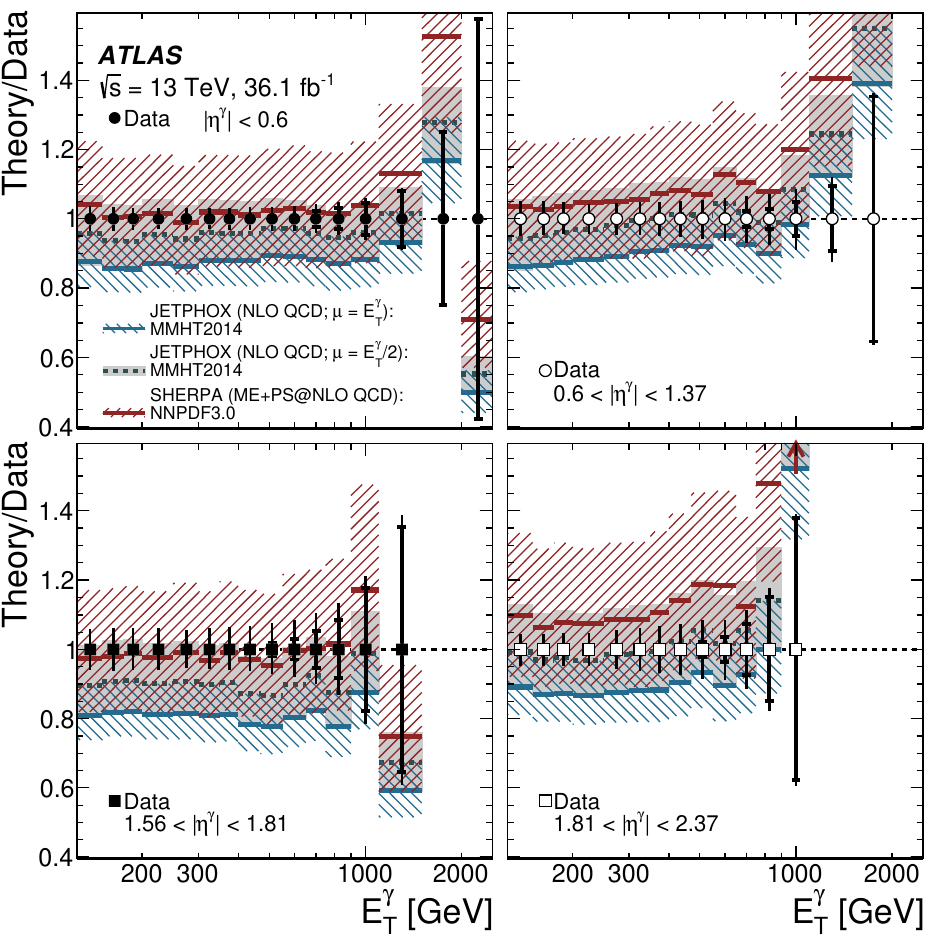
Figure 10 . The ratio of the NLO pQCD prediction of Jetphox with (cid:22) R = (cid:22) F = (cid:22) f = E (cid:13) , the T ratio of the NLO pQCD prediction of Jetphox with (cid:22) R = (cid:22) F = (cid:22) f = E (cid:13) = 2 and the ratio of T the ME+PS@NLO QCD prediction of Sherpa 2.2.2 to the measured di(cid:11)erential cross section for isolated-photon production as a function of E (cid:13) in di(cid:11)erent regions of j (cid:17) (cid:13) j . The symbols for the T data are centred at unity and the inner (outer) error bars represent the relative data statistical uncertainties (statistical and systematic uncertainties added in quadrature). The bands represent the full theoretical uncertainty, which includes the variations of the